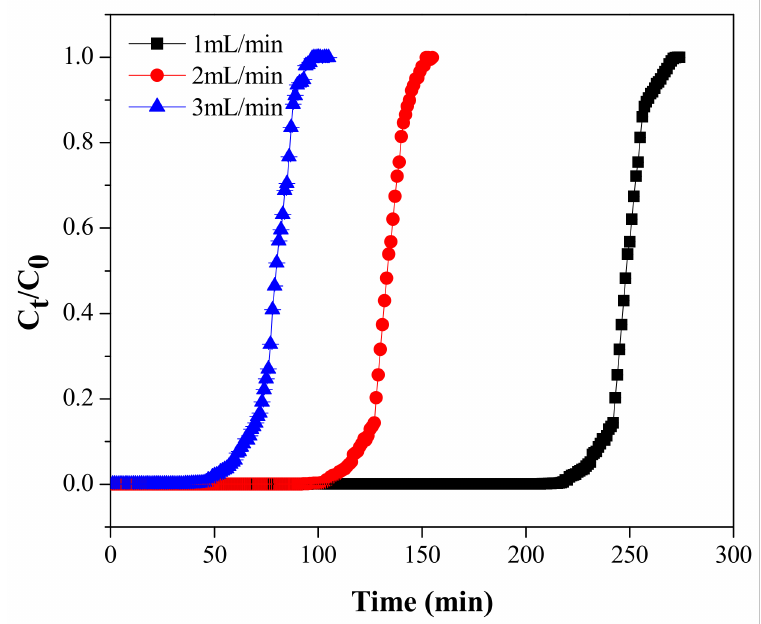
Figure 11. Cr(VI) adsorption breakthrough at different flow